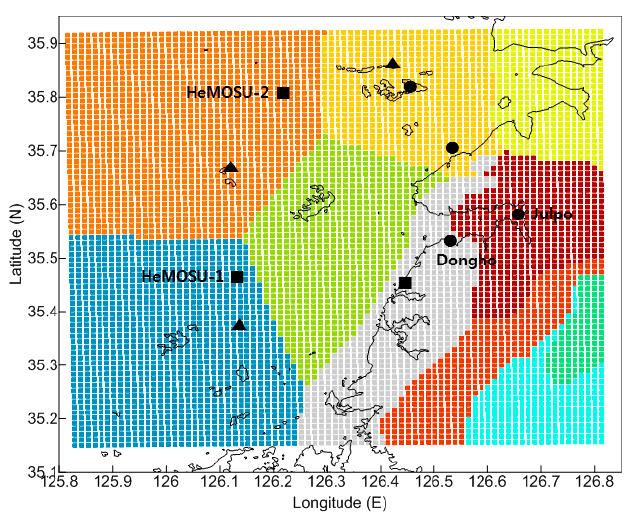
Figure 6. Wind sector clustering of the southwest offshore region.